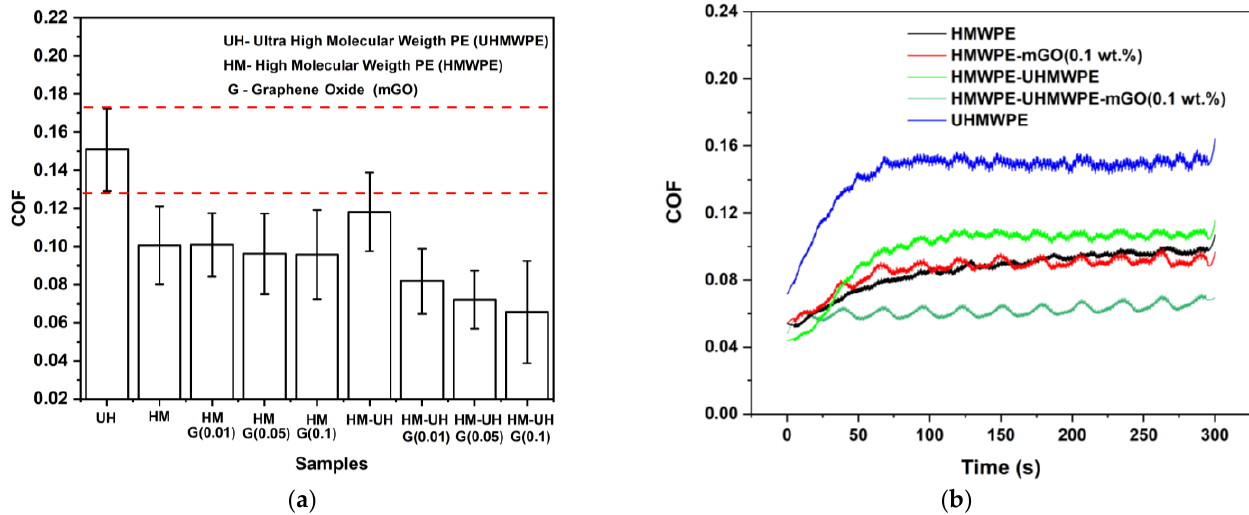
Figure 6. Friction coefficient results (COF) for the UHMWPE, HMWPE, HMWPE-mGO (0.01, 0.05 and 0.1 wt.%), HMWPE- UHMWPE (80/20 wt.%) and HMWPE-UHMWPE (80/20 wt.%)-mGO (0.01, 0.05 and 0.1 wt.%) ( a ) and the representative COF curves for the highlighted materials ( b ).